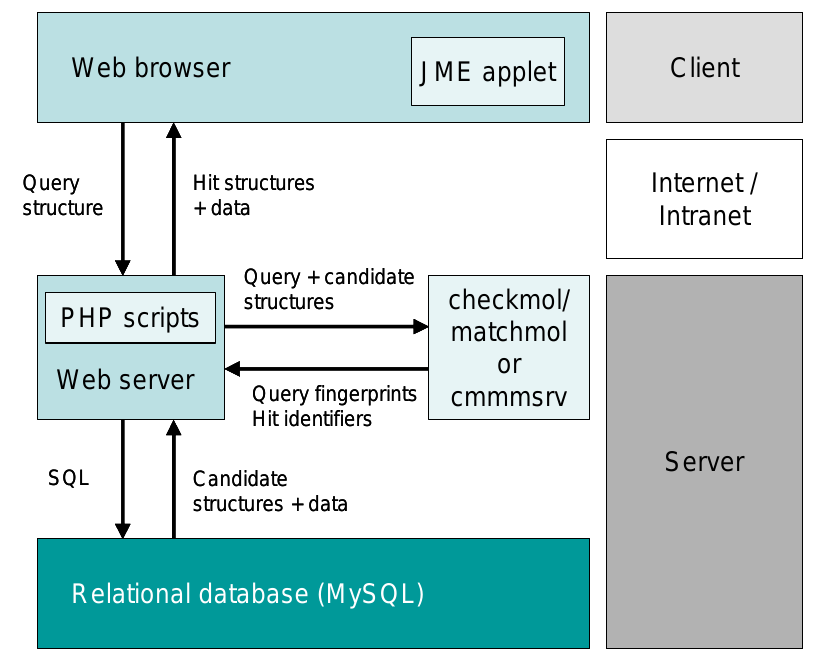
Figure 1. Client/server architecture of